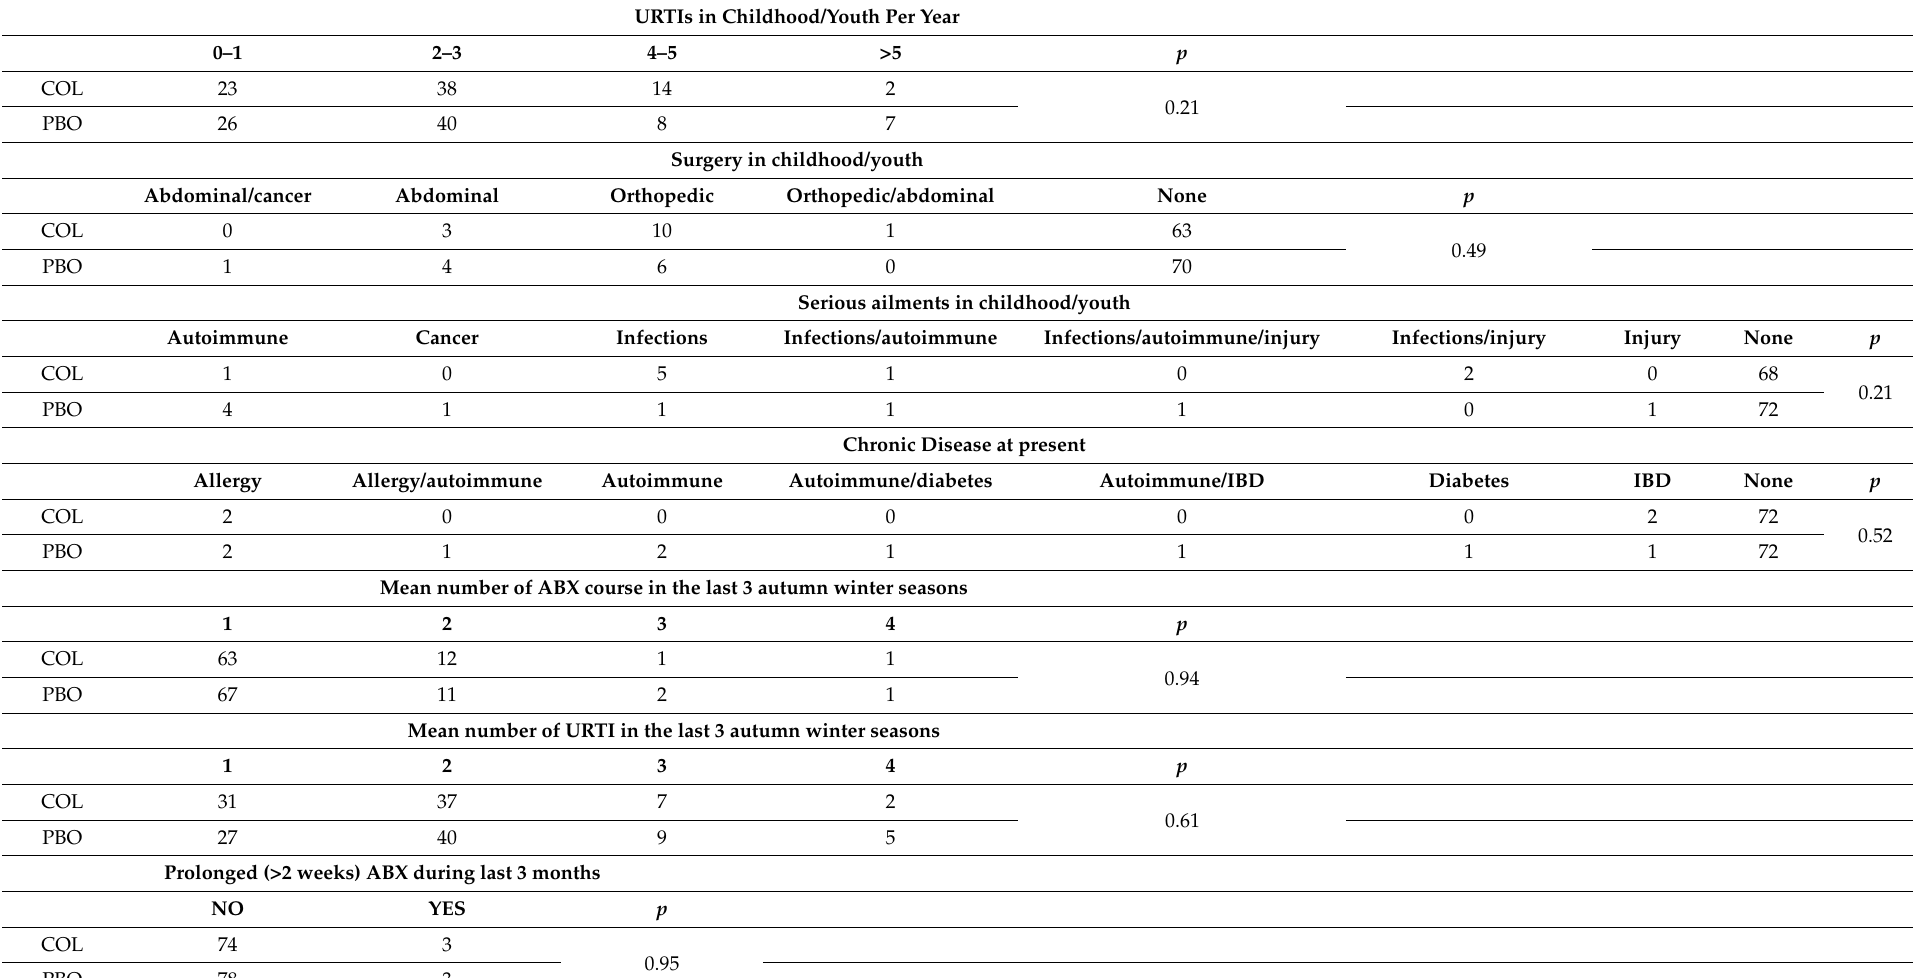
Table 1. The frequency of childhood diseases in study participants by allocation